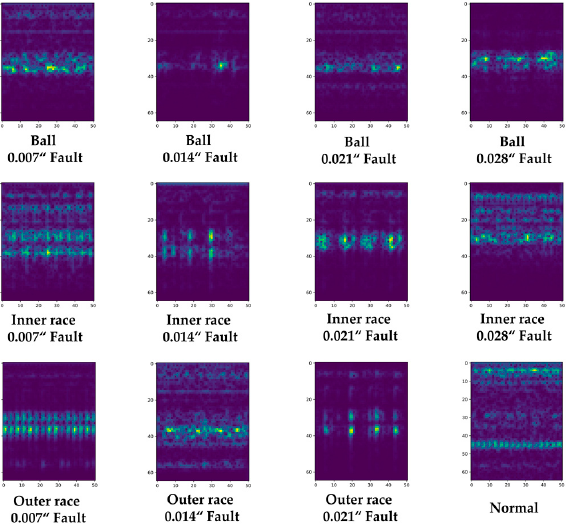
Figure 7. Generated Spectrogram corresponding to the raw vibration signal of each class shown in Figure 6.